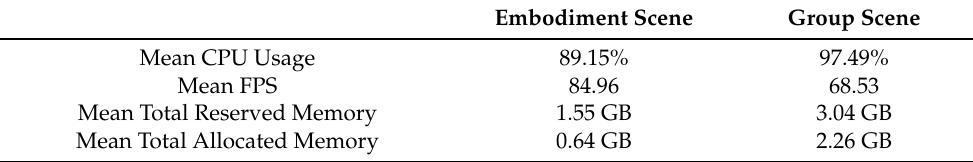
Table A12. Mean results for Test Condition